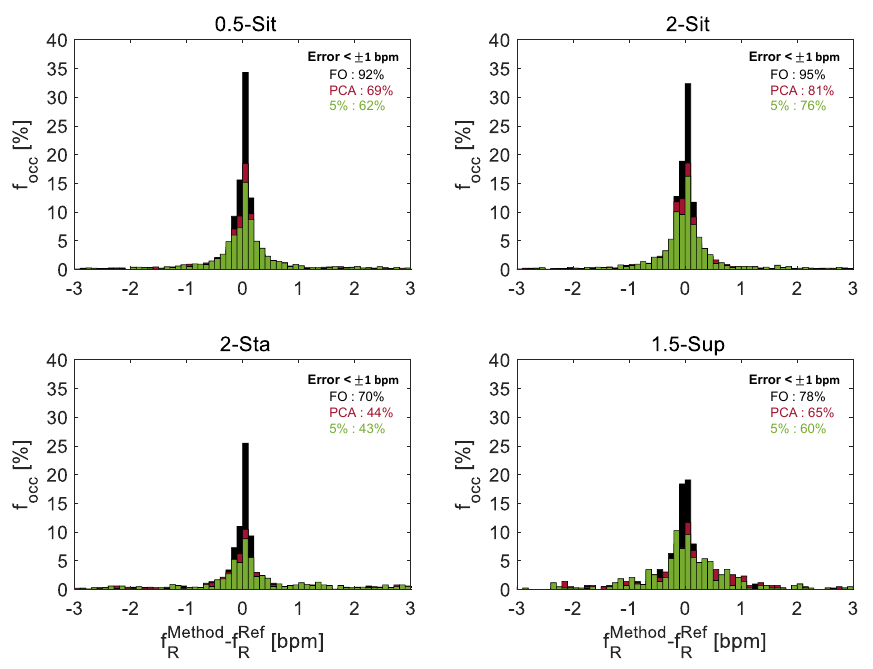
− f Ref ) per each trial and for each technique (in black R R